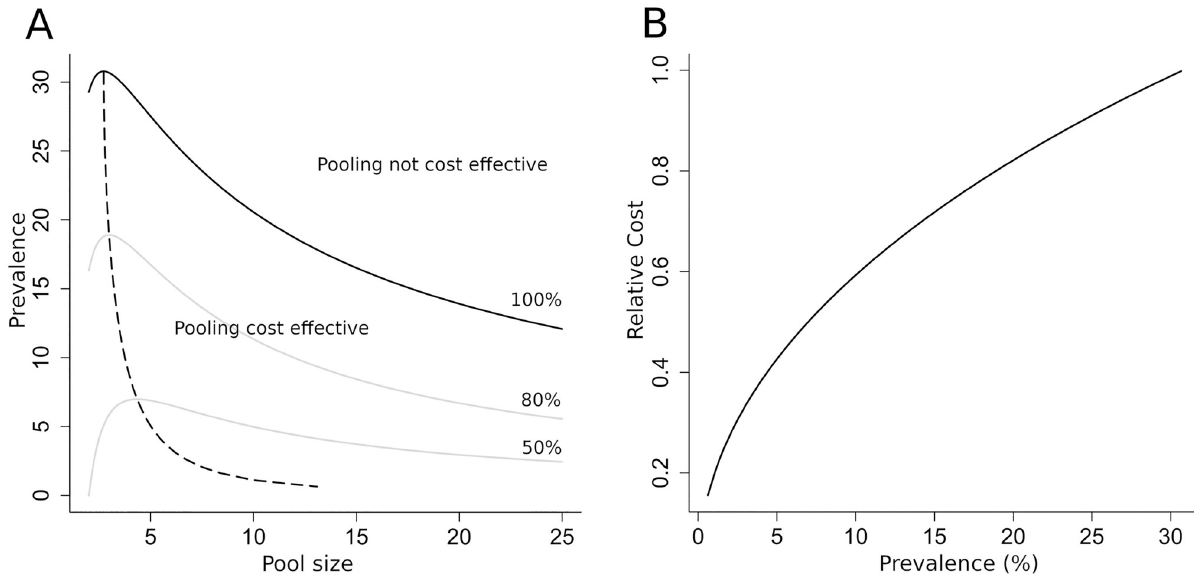
Fig 1. Expected relative cost as a function of prevalence and pool size. A) Combinations of prevalence and pool size for which pooling is cost effective or not, on average. Solid line indicates combinations for which pooling and individual sampling are matched. Grey lines indicate contours for relative cost at 50% and 80% (as formulated by equation S5 in the SI). Dotted line shows most cost-effective pool size for a given prevalence. B) Relative cost of optimum pool size as a function of prevalence. Pool sizes for prevalence are given by the dotted line in panel A.